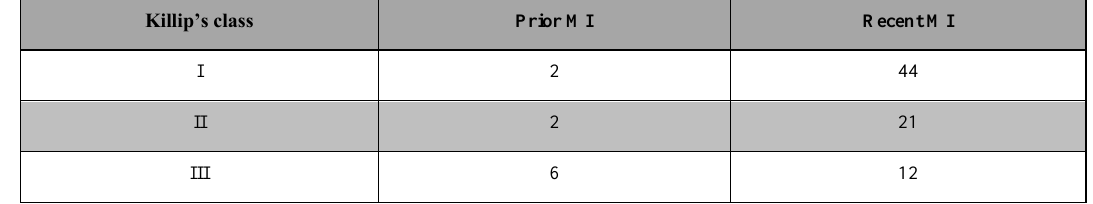
Table 4. Comparison of Killip’s class between recent and past MI